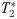
Single subject acquisition of T2* maps acquired with (a) ME-MP2RAGE, (c) ME-FLASH and (e) their difference, and test-retest reproducibility evaluation with voxel-by-voxel correlation 2D histograms for (b) ME-MP2RAGE, (d) ME-FLASH, and (f) ME-MP2RAGE versus ME-FLASH.